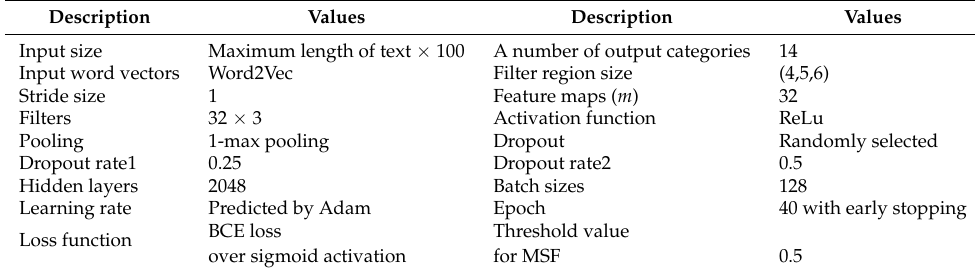
Table 4. CNN model settings.